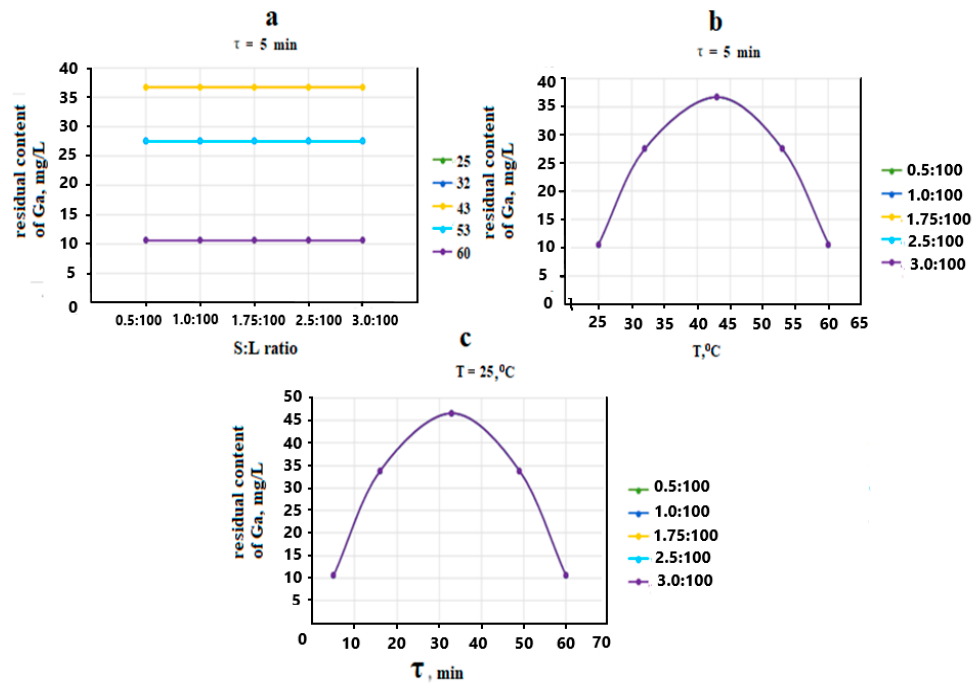
Figure 3. The influence of the studied factors on the residual content of Ga 3+ in the liquid phase of the “natural zeolite–In 3+ –Ga 3+ ” system. ( a ) the S:L ratio; ( b ) temperature, ◦ C; ( c ) time, min. The kinetic curves of the sorption of the Ga(III) cations on the sorbent amount for all temperatures and in the entire studied time interval are rectilinear (Figure 2a). As seen in this Figure, the norm of the sorbent has no effect on the process of sorption of the Ga 3+ cations by natural zeolite. For example, in 5 min process at S:L = (0.5–3):100 and 25 °C, 63.3% is sorbed.